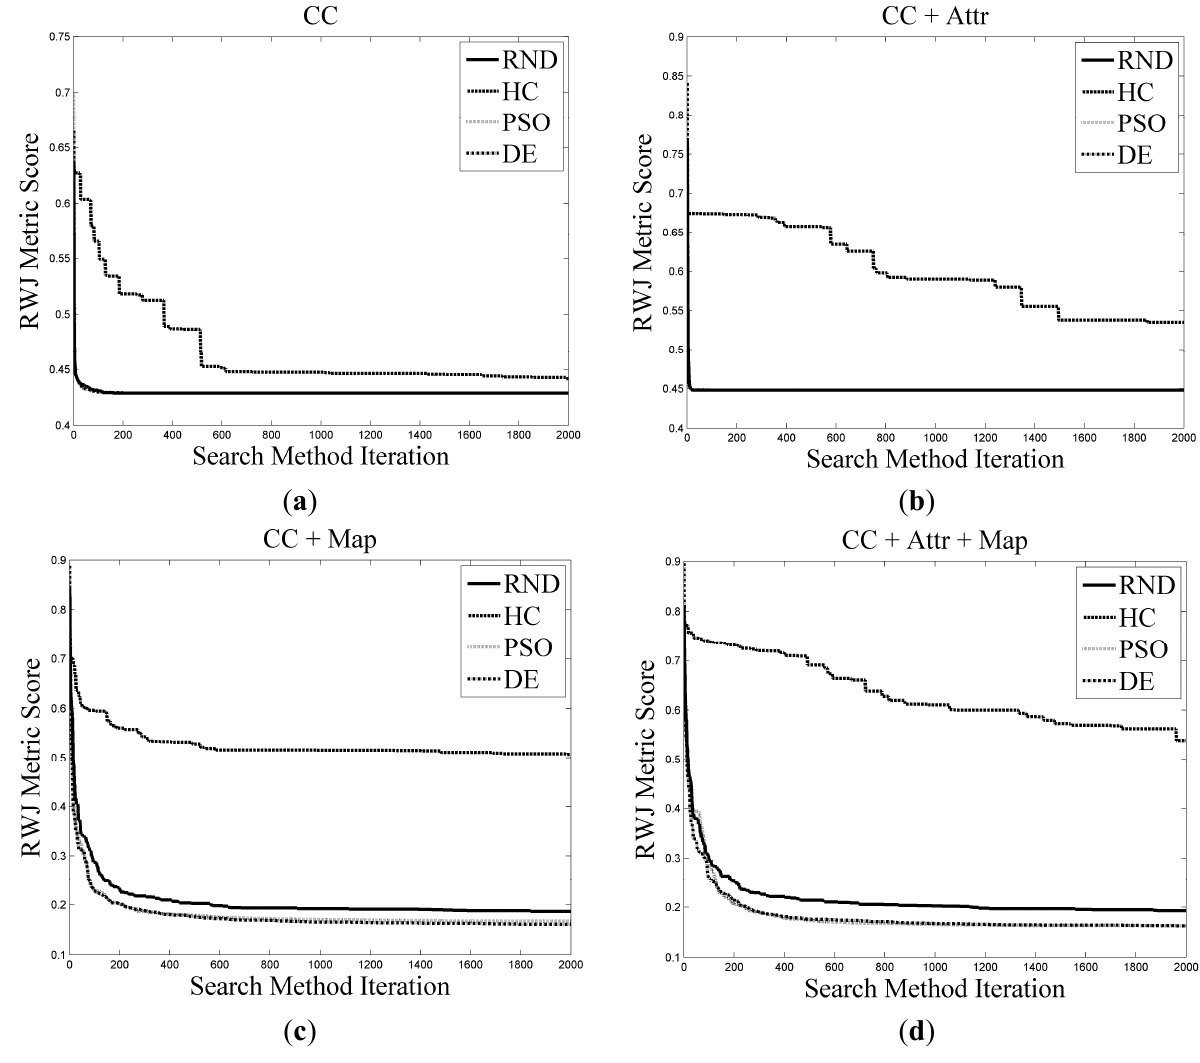
Figure 9. Search method profiles for the four method variants, namely CC ( a ), CC + Attr ( b